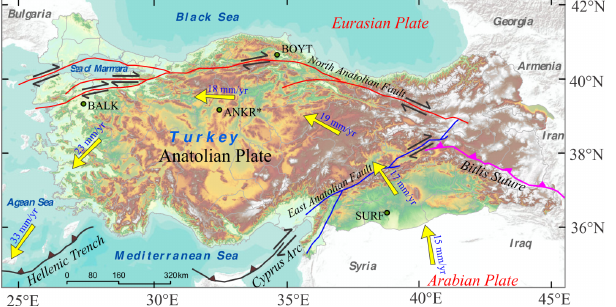
Figure 1: Large-scale tectonic features of the Turkey, the yellow arrows show approximate plate motions relative to stable Eurasia.